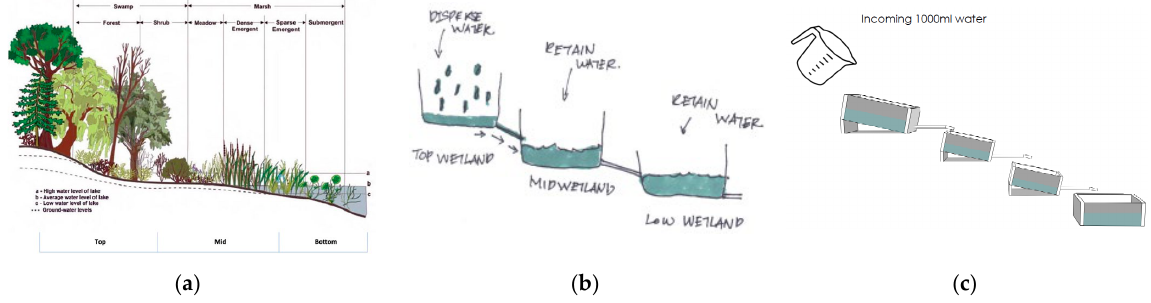
Figure 6. ( a ) Parts of a typical wetland. ( b ) Sketch replicating 3 wetland parts. ( c ) Sketch showing the experiment process. Photos: ( a ) [27], Illustrations: ( b , c ) [28].